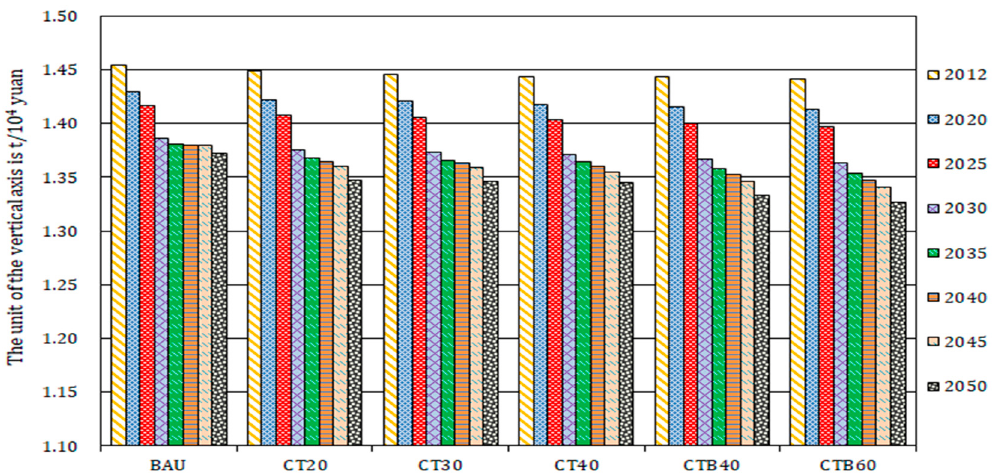
Figure 2. The trend in China’s carbon intensity change under different scenarios.